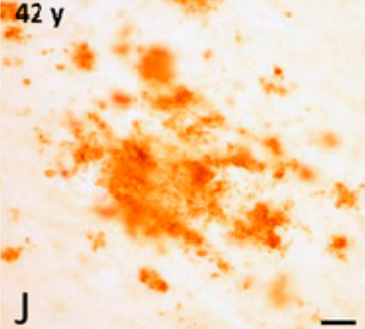
Figure 10. High-magnification photomicrographs showing a diffuse APP/A β -ir (immunoreactive) plaques in the frontal cortex of a 42-year-old female gorilla. Bar = 25 μ m. Reprinted from Neurobiology of Aging , 39, Perez S.E., Sherwood C.C., Cranfield M.R., Erwin J.M., Mudakikwa A., Hof P.R., Mufson